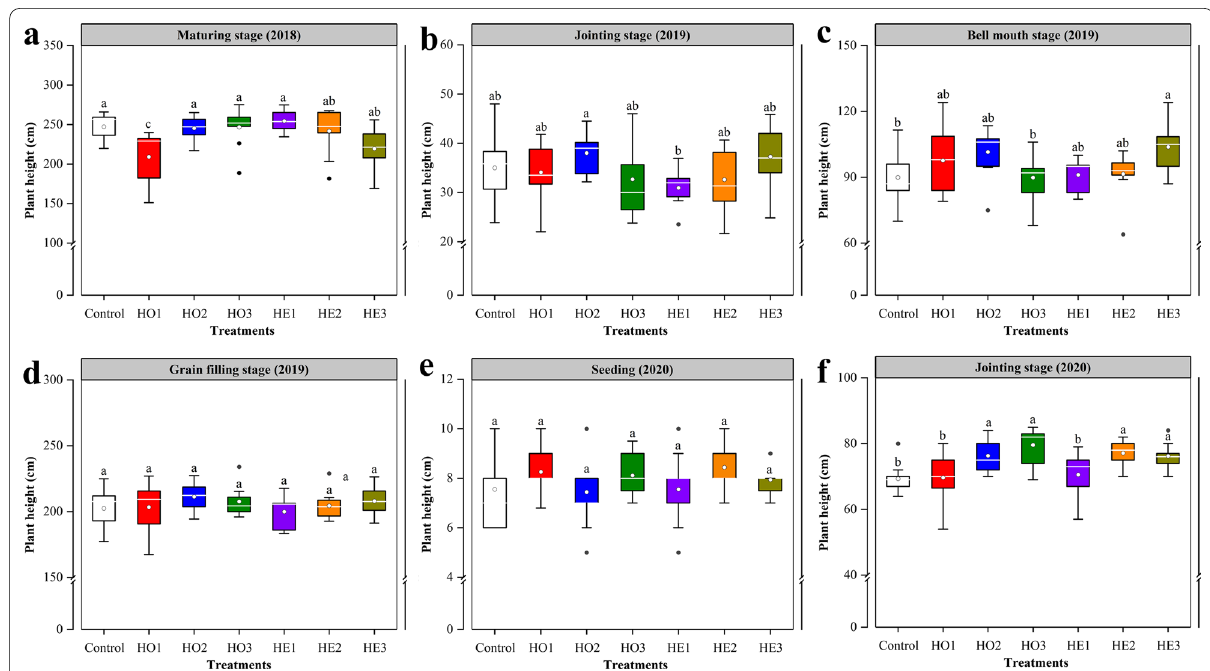
Fig. 4 Plant height as affected by biochar application methods and amount. a Plant height at maturing stage in 2018. b – d Plant height at jointing, bell mouth and grain filling stage in 2019. e and f Plant height at seeding and jointing stage in 2020. The upper and lower box edges of boxes show the 75th and 25th percentiles, respectively; the ‘ ● ’ shows outliers; ‘ ○ ’ shows the average value; the interior horizontal bar marks the median line. HO, homogeneous application; HE, heterogeneous application; 1, 2 and 3, biochar application was 10, 20 and 40 t ha − 1 , respectively, in both HO and HE treatments, Control, biochar application was 0. The same lowercase letter over each box in the same cropping stage represents no significant difference ( P > 0.05) between treatments